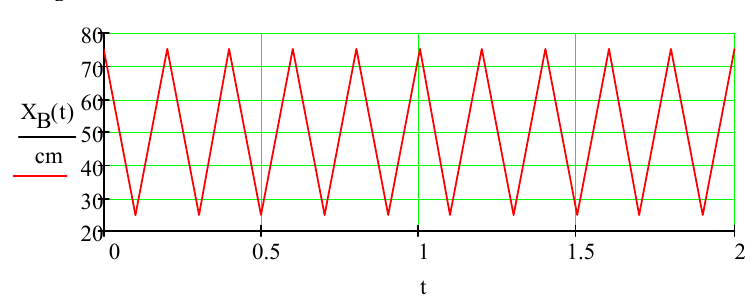
Figure 6. Point B motion graph obtained in MathCad.